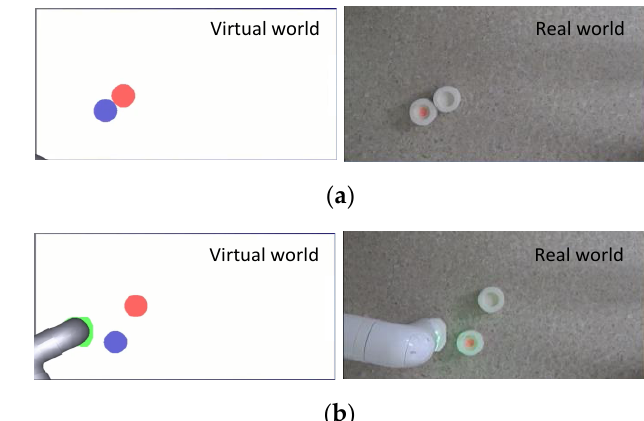
Figure 11. Scattering algorithm for object singulation.